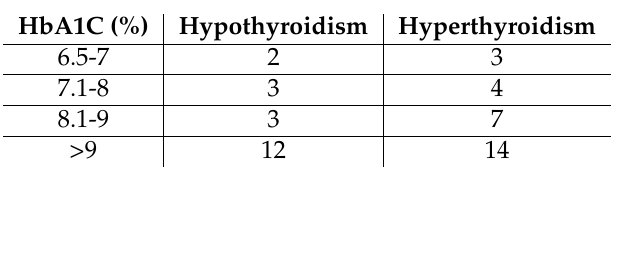
Table 3. Thyroid dysfunction based on glycemic